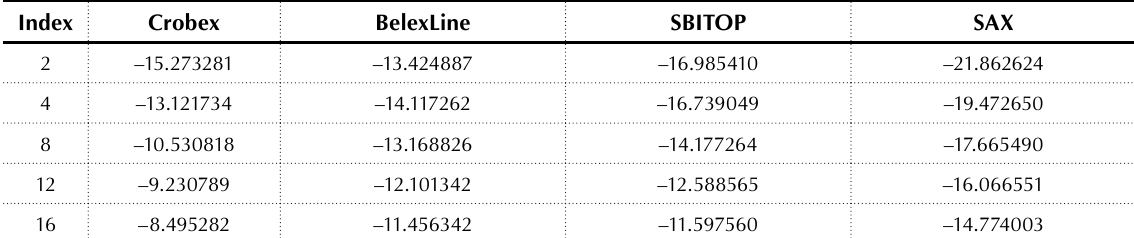
Table 4. Variance ratio test